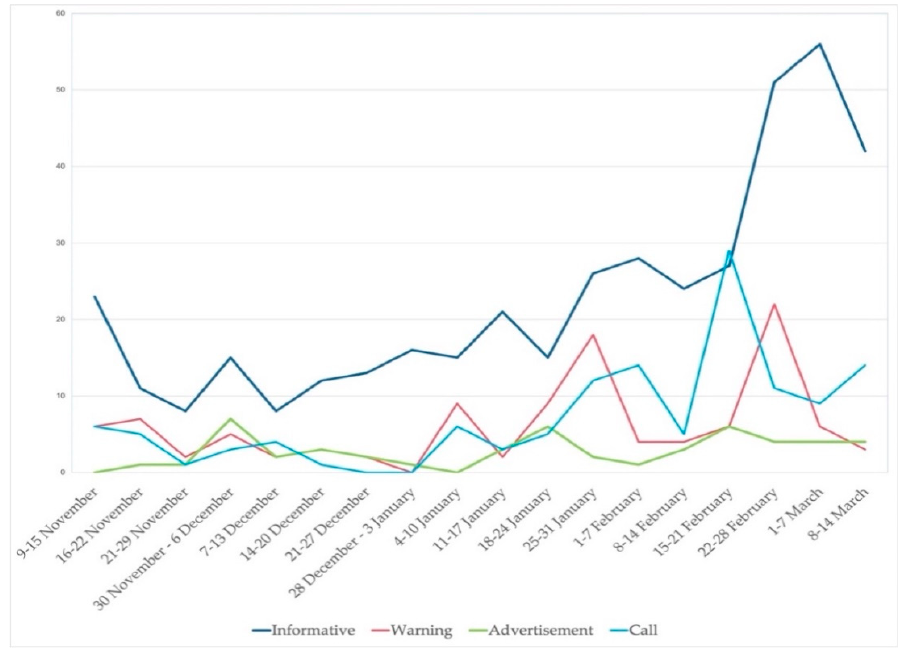
Figure 4. Evolution of the nature of the messages.